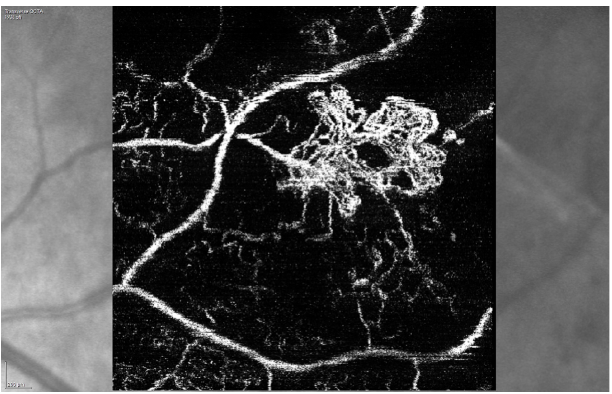
Figure 7. Optical coherence tomography angiography (OCTA) analysis demonstrating perifoveal neovascularization.